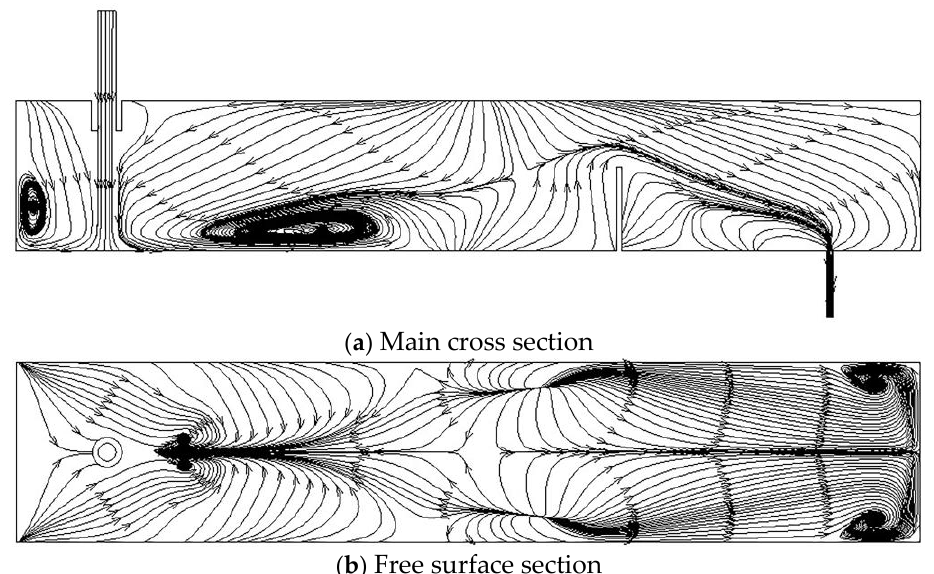
Figure 15. Fluid flow in the case of actual tracer (26.42%) at 25 s: ( a ) Main cross section; ( b ) Free surface section.